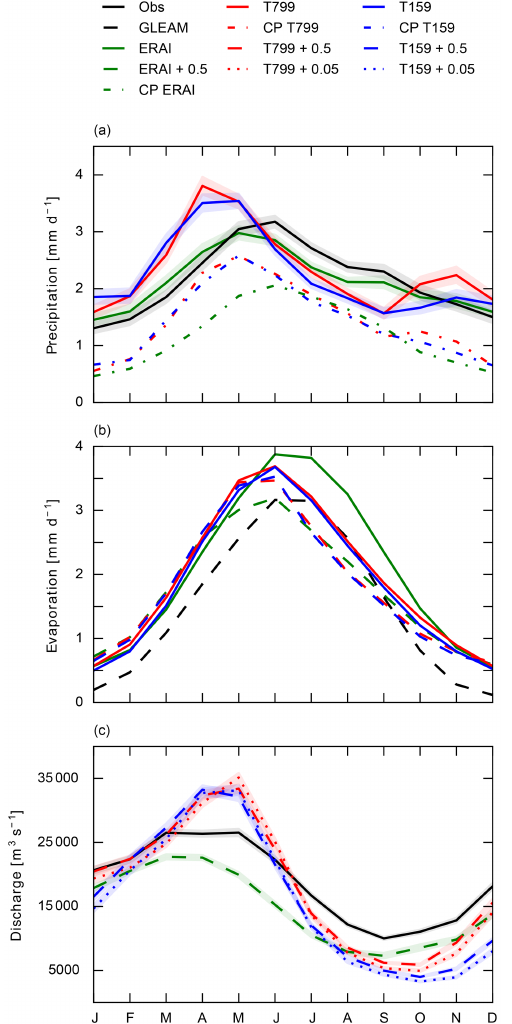
Figure 11. Monthly averages of (a) basin-averaged daily precipita- tion sums (mmday − 1 ), (b) basin-averaged daily evaporation sums (mmday − 1 ), and (c) daily discharge (m 3 s − 1 ) at Vicksburg for the Mississippi basin. Black lines are observations; green is ERAI. The red and blue lines are respectively the high-resolution (T799) and low-resolution (T159) GCMs. The dash–dotted lines indicate con- vective precipitation, dashed lines output from the 0.5 ◦ GHM, and dotted lines output from the 0.05 ◦ GHM. The shaded bands indicate the 95% confidence